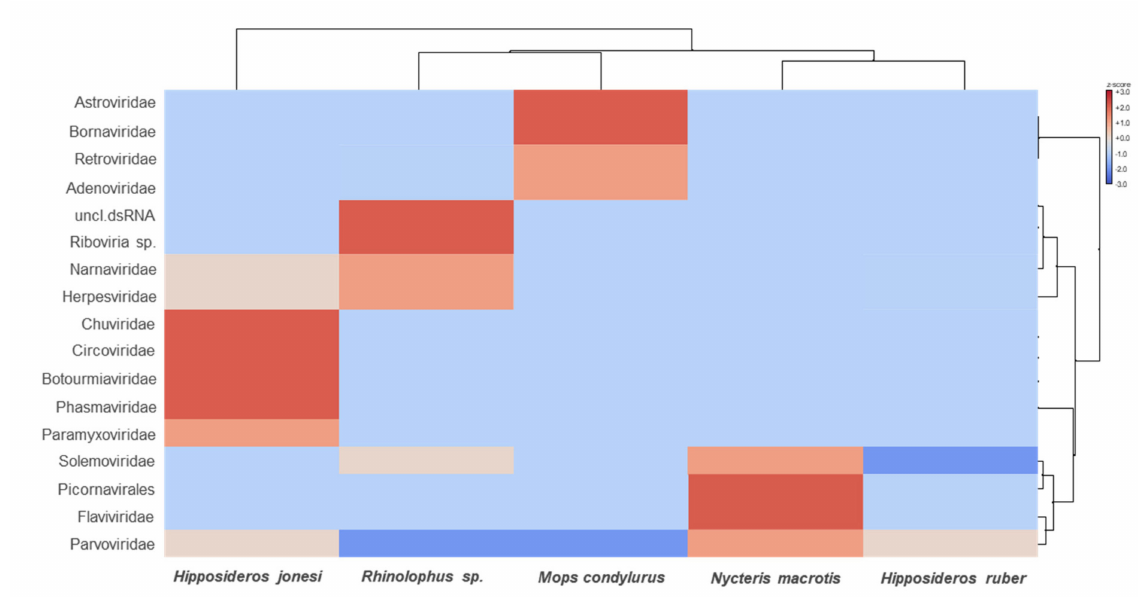
Figure 2. Heat map visualizing the most abundant virus families in each pooled bat sample. The bat species are listed in the bottom text row. The names of the virus families are presented in the left text column. Heat maps are color-coded based on row z-scores.